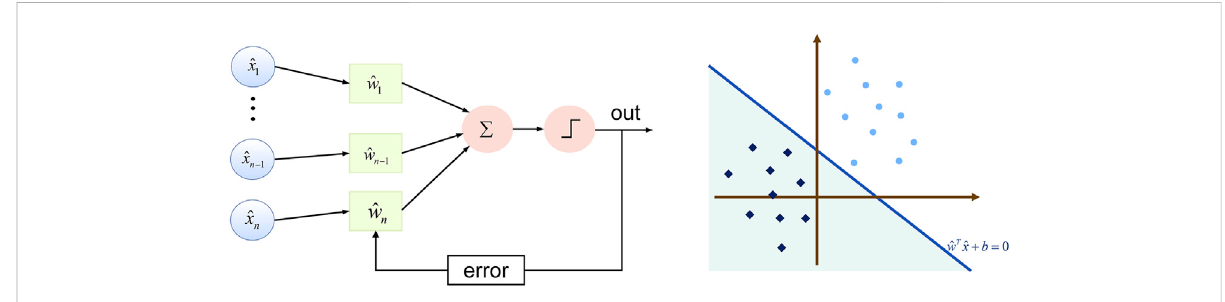
FIGURE 1 Models of classical perceptual machines (left) and applications to classi fi cation